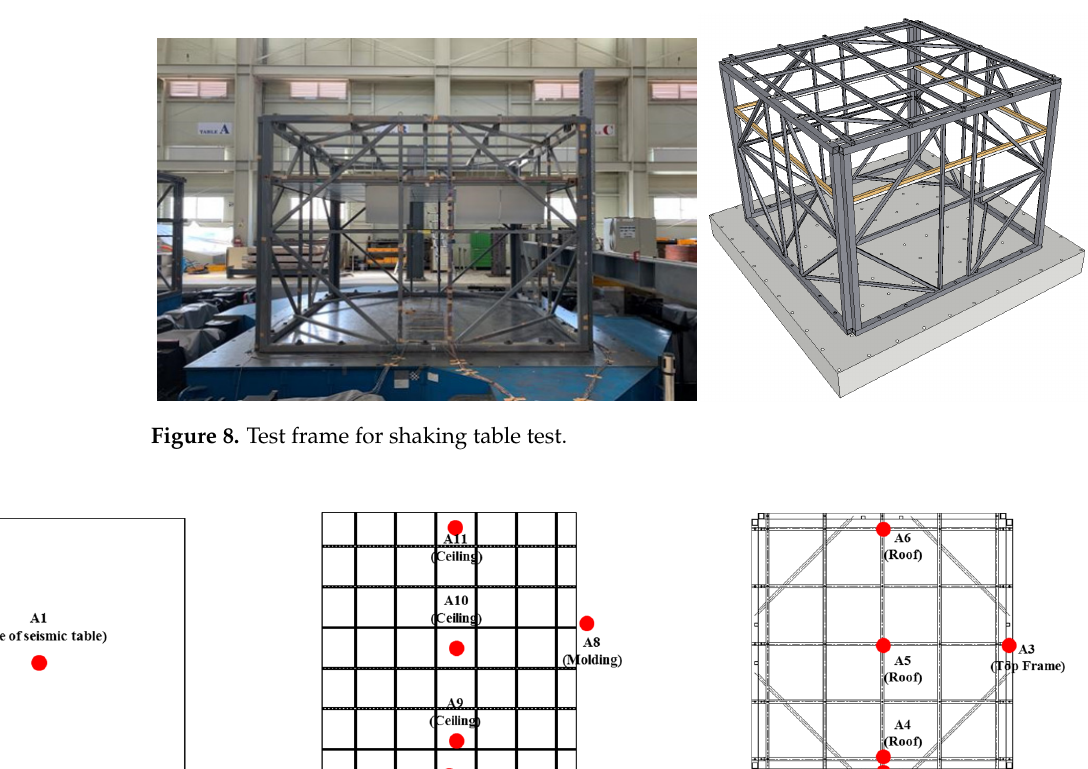
Figure 9. Accelerometer installation locations for the brace specimens: ( a ) base of the seismic table, ( b ) top frame (roof), ( c ) ceiling surface.